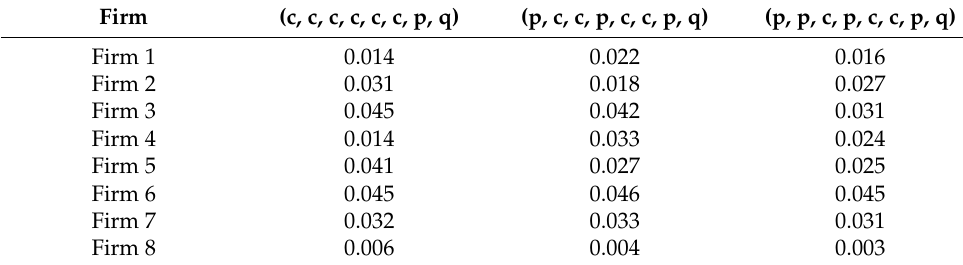
Table 6. Profits of the Nash equilibrium.